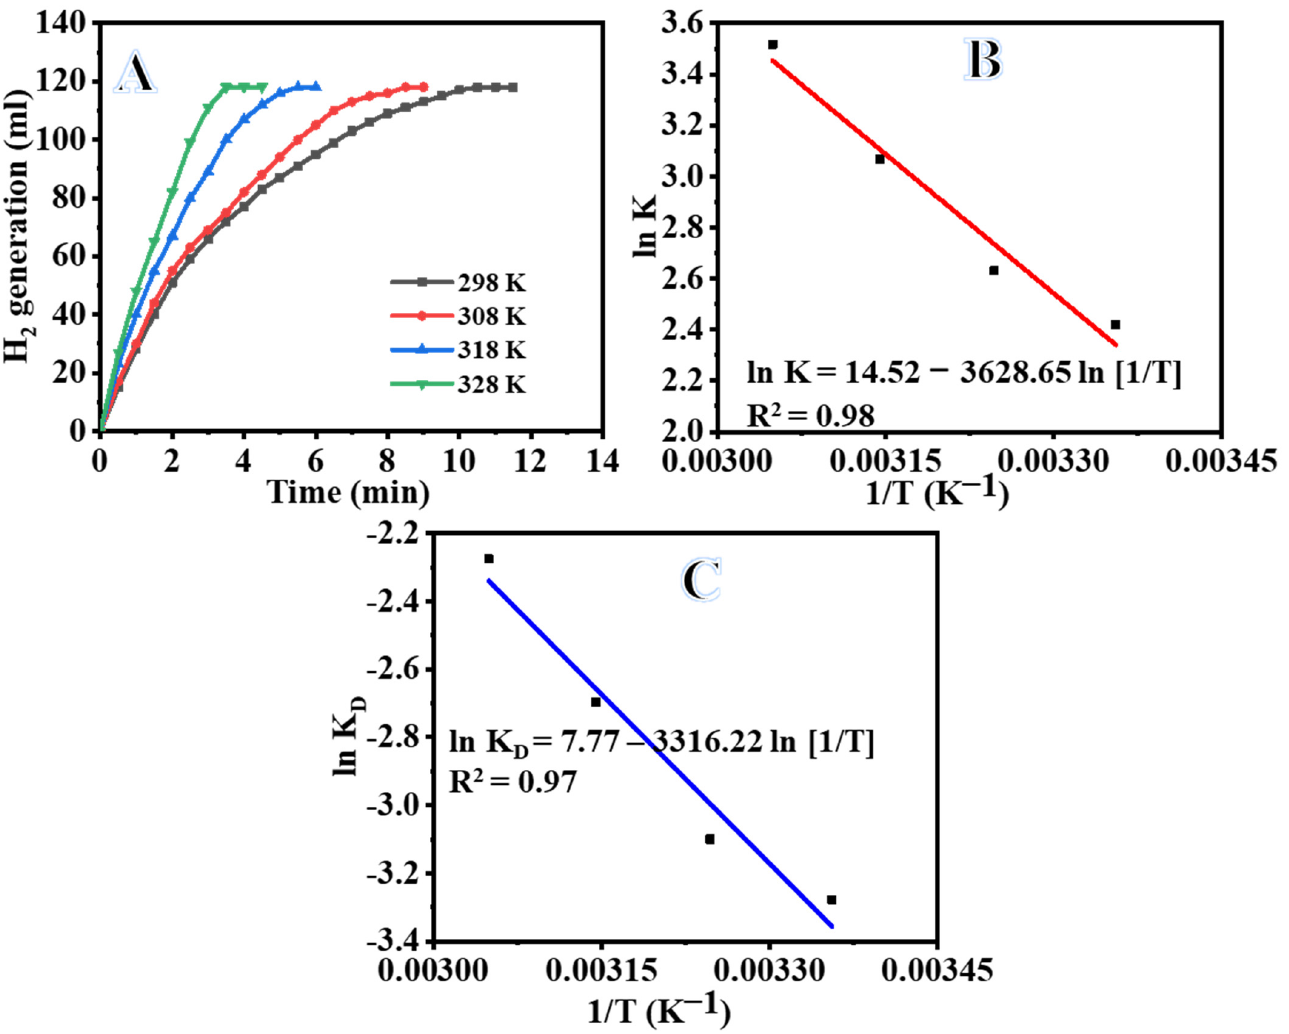
Figure 9. Influence of temperature on the dehydrogenation of SBH ( A ), the logarithmic value of the K for H 2 production as a function of the inverse of the temperature ( B ), and the logarithmic value of the K D as a function of the inverse of the temperature ( C ). [Amount of catalyst = 100 mg of Ni 0.3 Co 0.7 @ PVDF ‐ co ‐ HFP NFs membrane and [SBH] = 1 mmol].